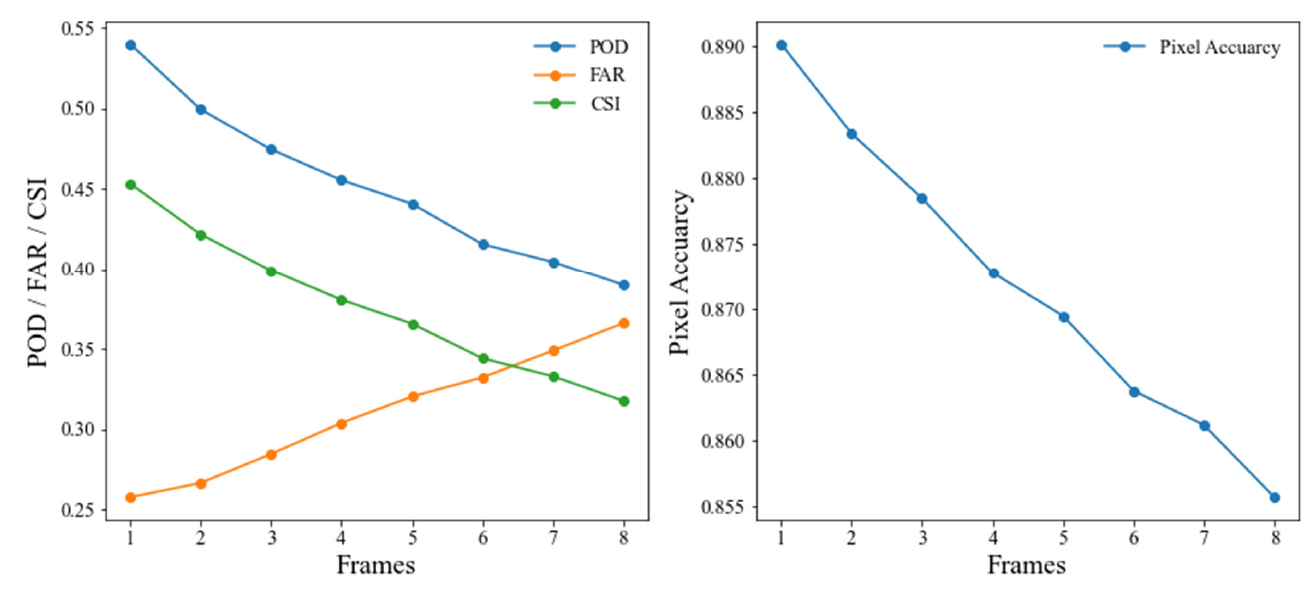
Figure 11. The change in the detection results in the prediction step.